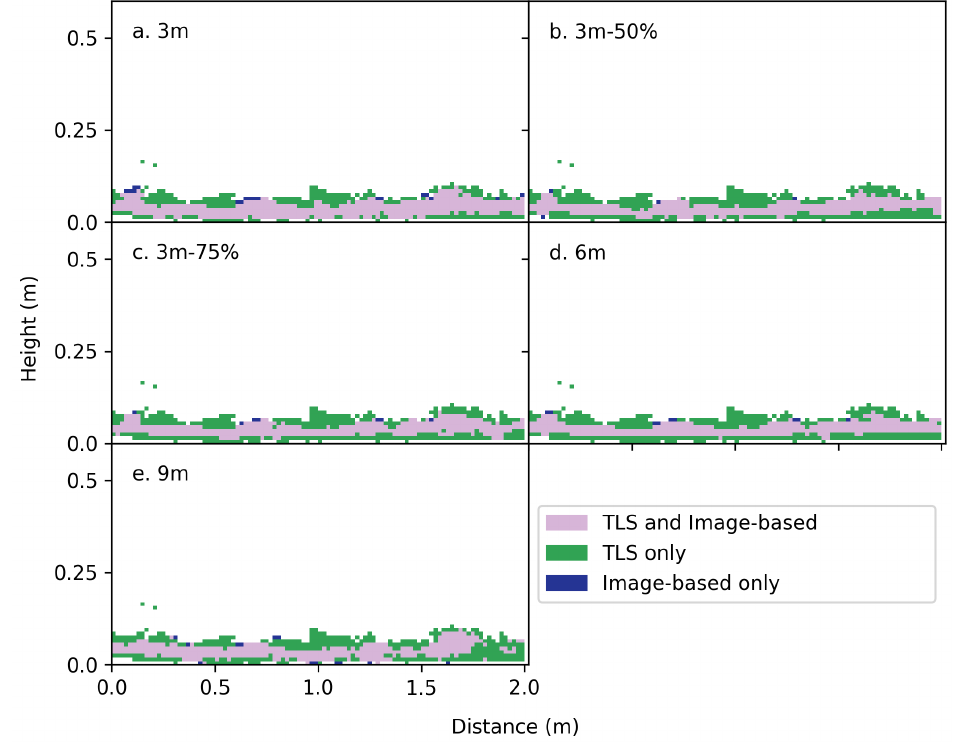
Figure 7. Differences in one horizontal row (2cm wide) between the TLS and image-based voxel representations of the point clouds generated for Plot